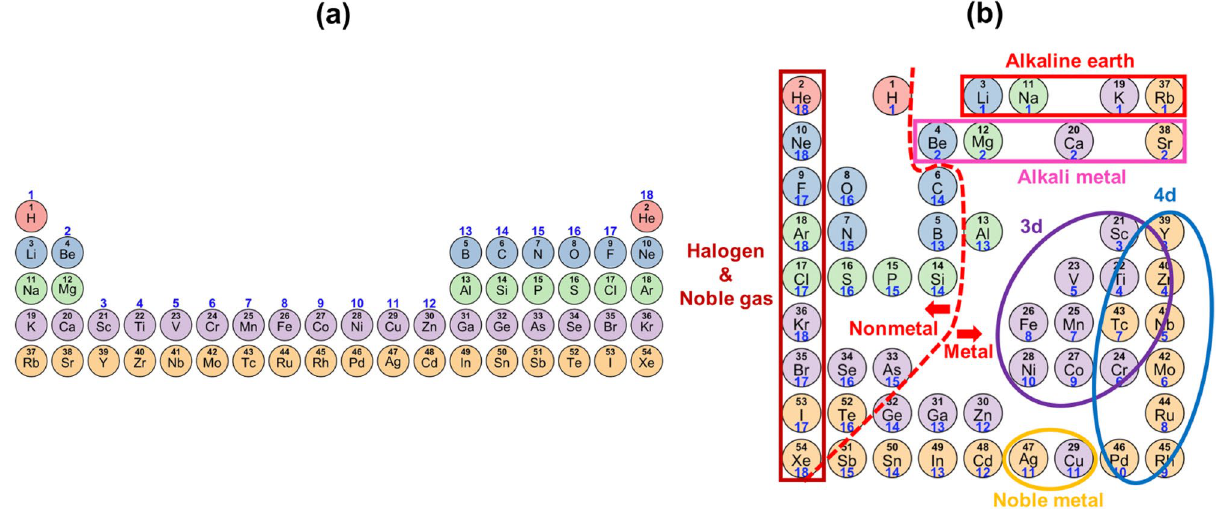
Figure 2. ( a ) The currently most common periodic table of the elements. ( b ) Square PTG table created from the training data of 39 features of the 54 elements. The elements are colour-coded by periods and numbered by atomic numbers. The number shown in blue below each element symbol represents the group number (the column in the standard periodic table).